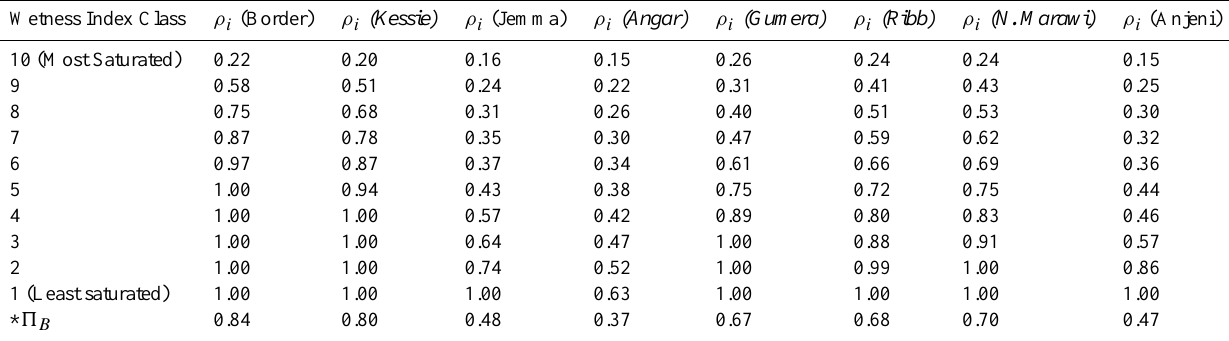
Table 1. Effective depth coefficients ( ρ i ) for each wetness index class and watershed in the Blue Nile Basin model from Eq. (8). The 5 B is determined from baseflow separated runoff of the streamflow hydrograph and distributed.